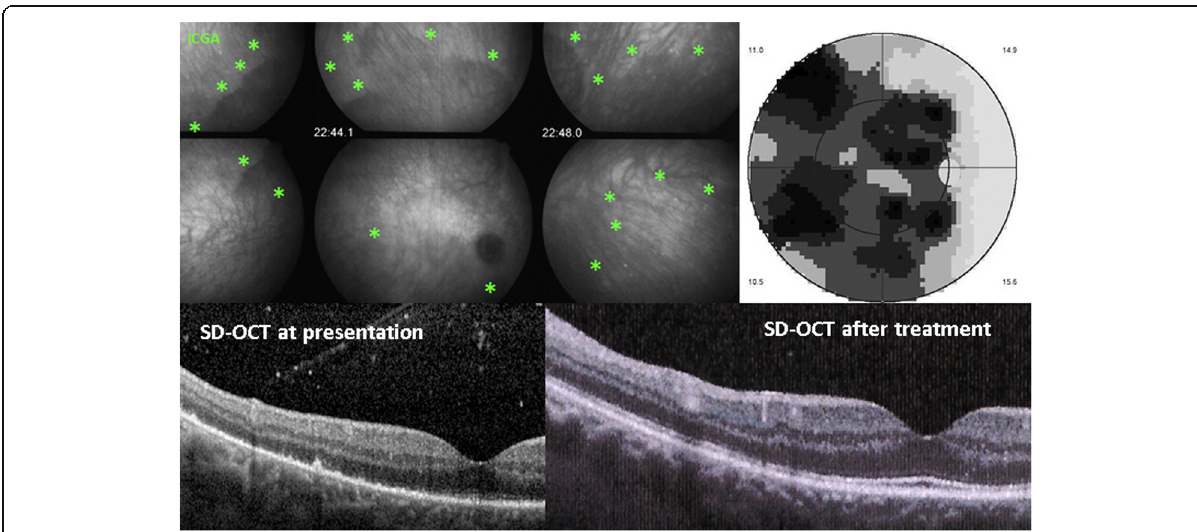
Fig. 11 SD-OCT imaging of loss of photoreceptor outer segments in a case of syphilitic secondary choriocapillaritis. Choriocapillaris non-perfusion shown by green asterisks (top left sextet), causing transient loss of photoreceptor outer segments (bottom left), as well as severe visual field loss (top right). After treatment, the photoreceptors are partially reconstituted (bottom